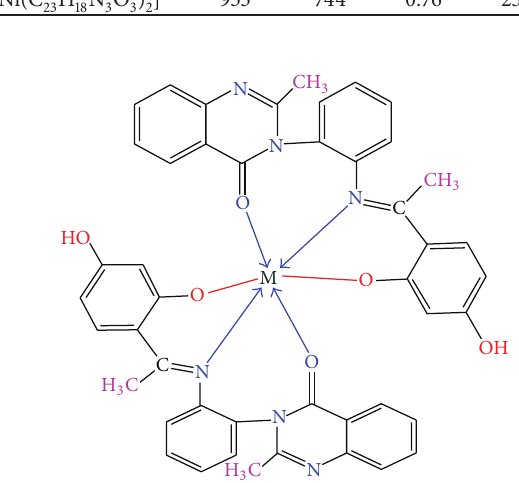
Figure 1: Proposed structures of Cu(II) and Ni(II).